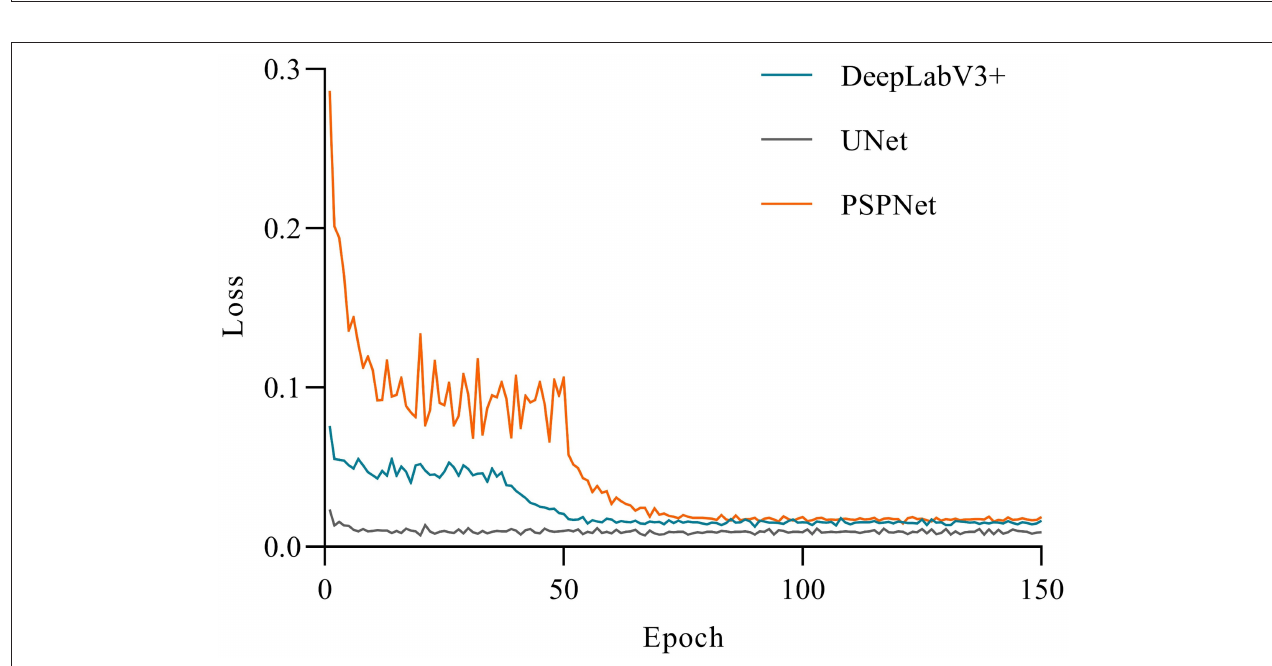
FIGURE 5 | Comparison of the variations of accuracy.